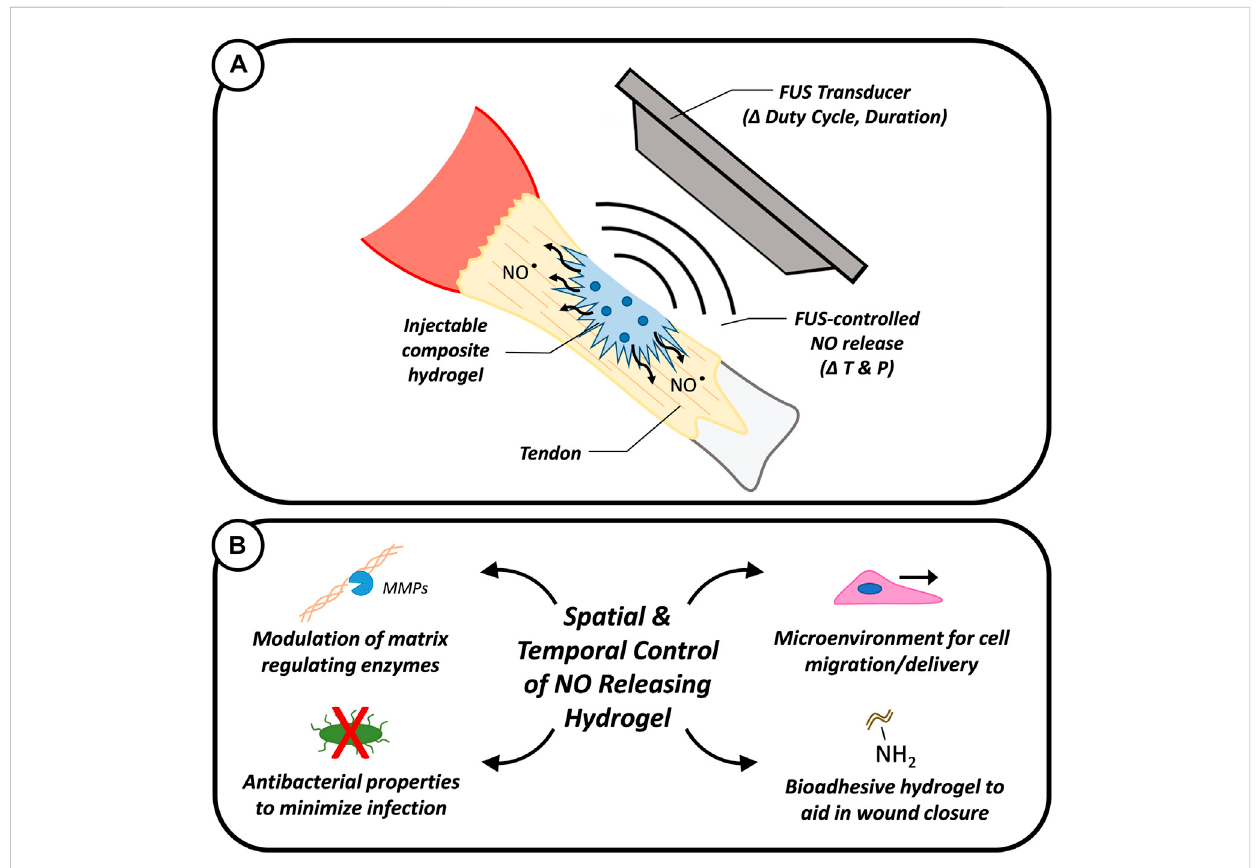
FIGURE 1 Graphic showing the intended use of FUS to remotely modulate the release of NO from composite hydrogels to aid in tendon repair via controlled temperature (T) and pressure (P) stimulus (A) . The spatial and temporal controlled release of NO could enable the modulation of matrix regulating enzymes and the minimization of bacterial infections while thecomposite hydrogel could providea physical microenvironment to support cell adhesion and migration (B)